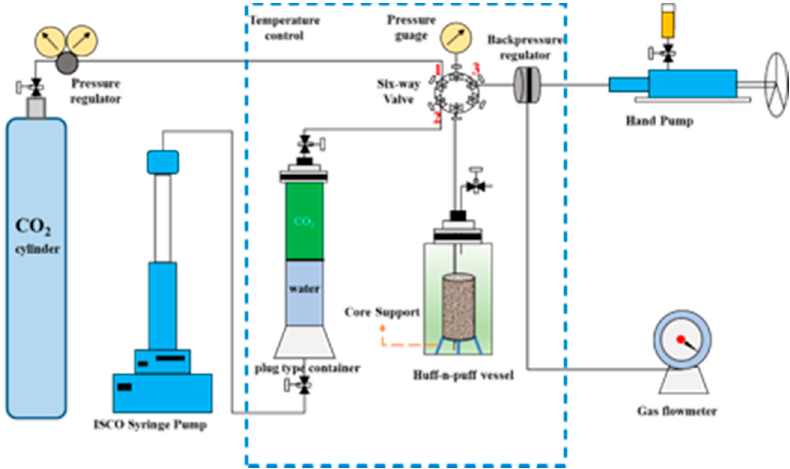
Figure 4. Schematic of the apparatus for the CO 2 huff-n-puff experiments. The red numbers 1, 2 and 3 denote three different valves in the six-way valve. 3 denote three different valves in the six-way